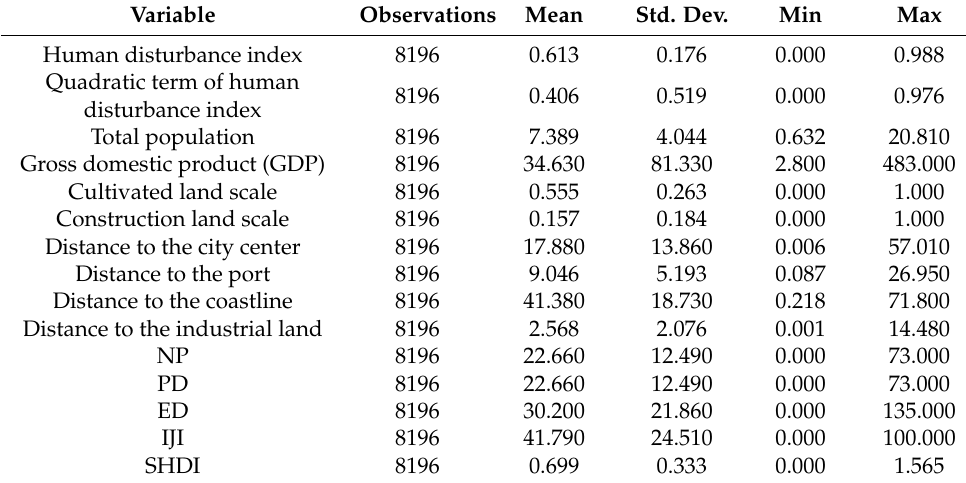
Table 10. Descriptive statistics of the variables.